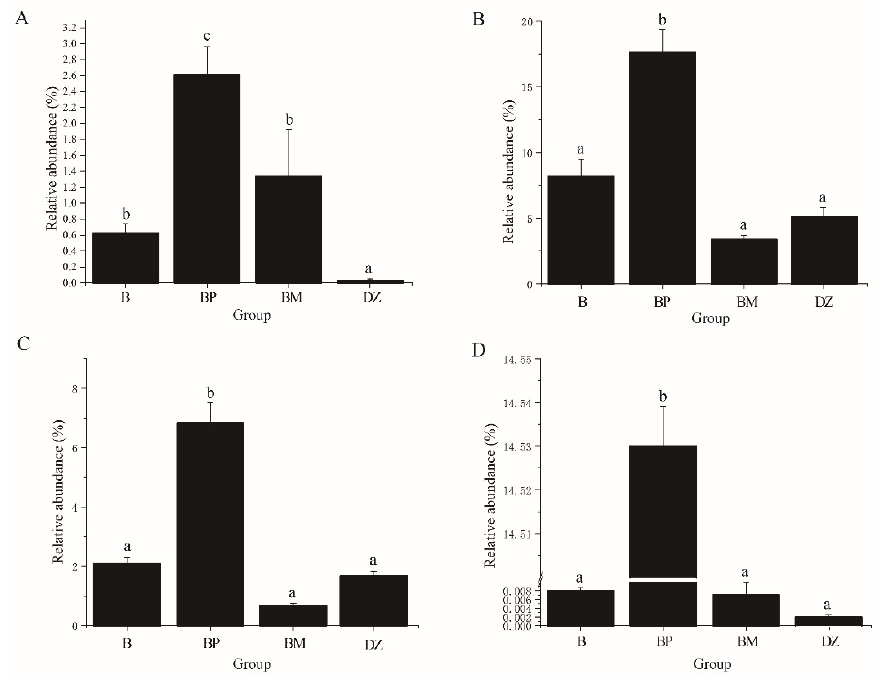
Figure 7. The relative abundance of Bacillus spp. ( A ), Donghicola spp. ( B ), Marivita spp. ( C ) and Oricola spp. ( D ) in different groups. Note: group B, a single B. pumilus BP-171, was added; the group BP, B. pumilus BP-171, and PHBV were added; the group BM, B. pumilus BP-171, and molasses were added; the group DZ, the control without any probiotics and carbon sources addition. Values with different superscripts are significantly different among treatments in each figure ( p < 0.05).